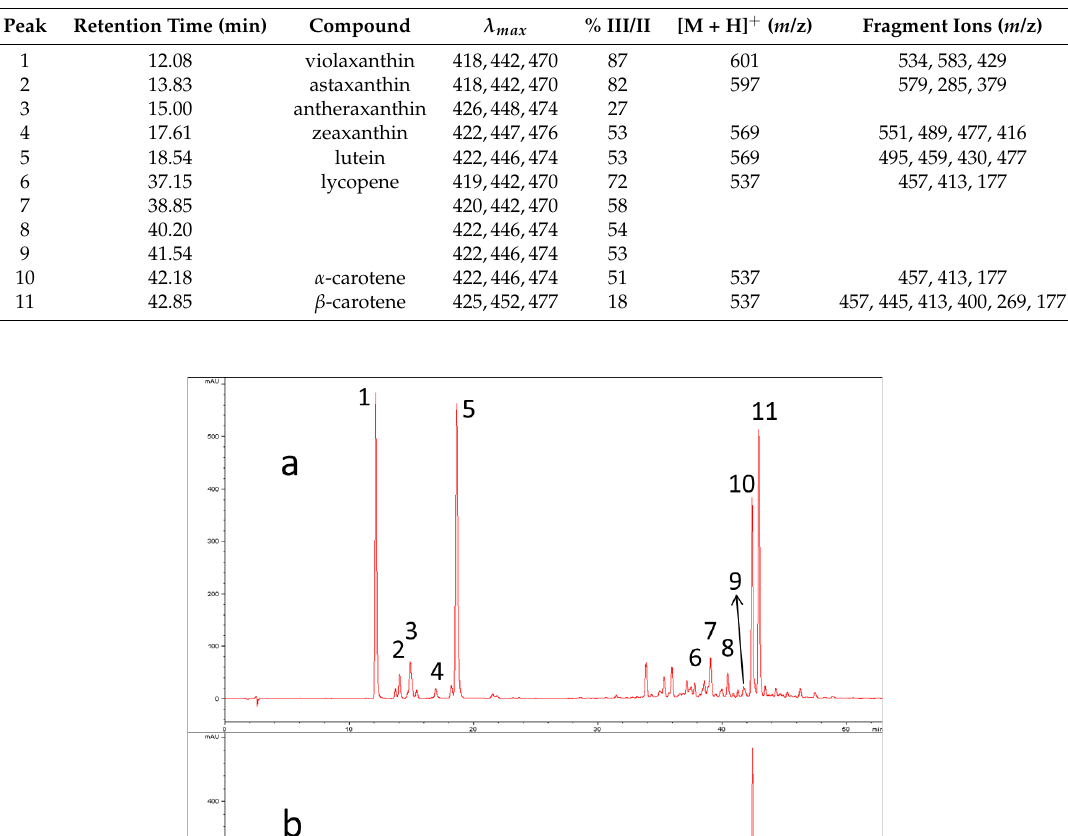
Table 1. Chromatographic, spectroscopic, and APCI–MS/MS mass spectrometric parameters of the tentatively identified carotenoid peaks (see Figures 1 and 2).